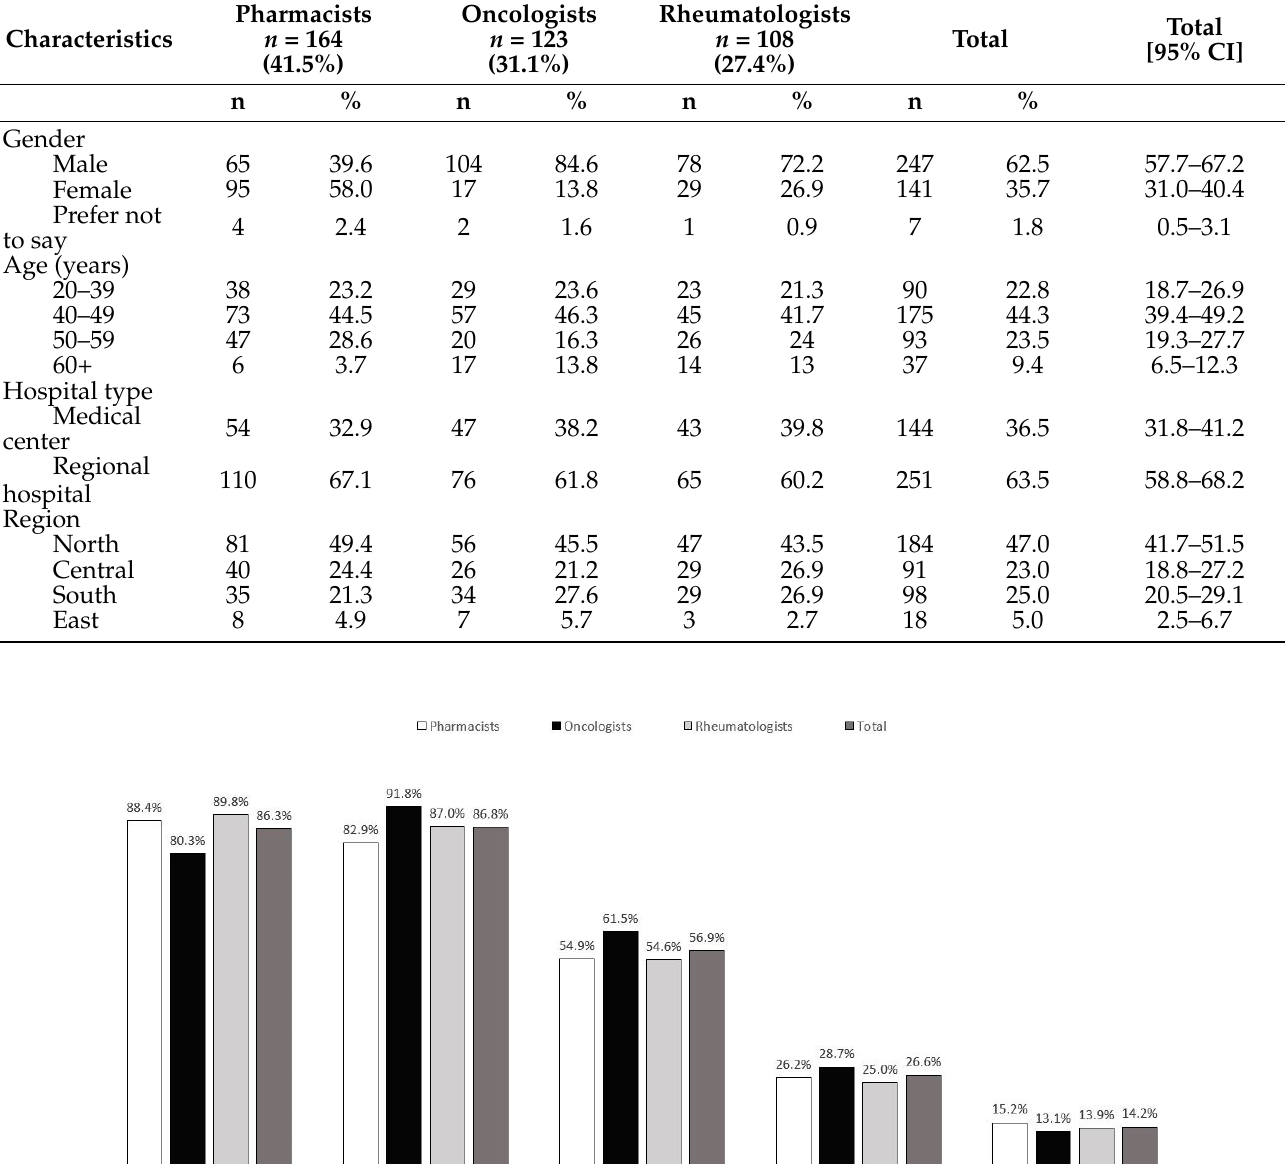
Table 1. Demographic characteristics of respondents ( n = 395).